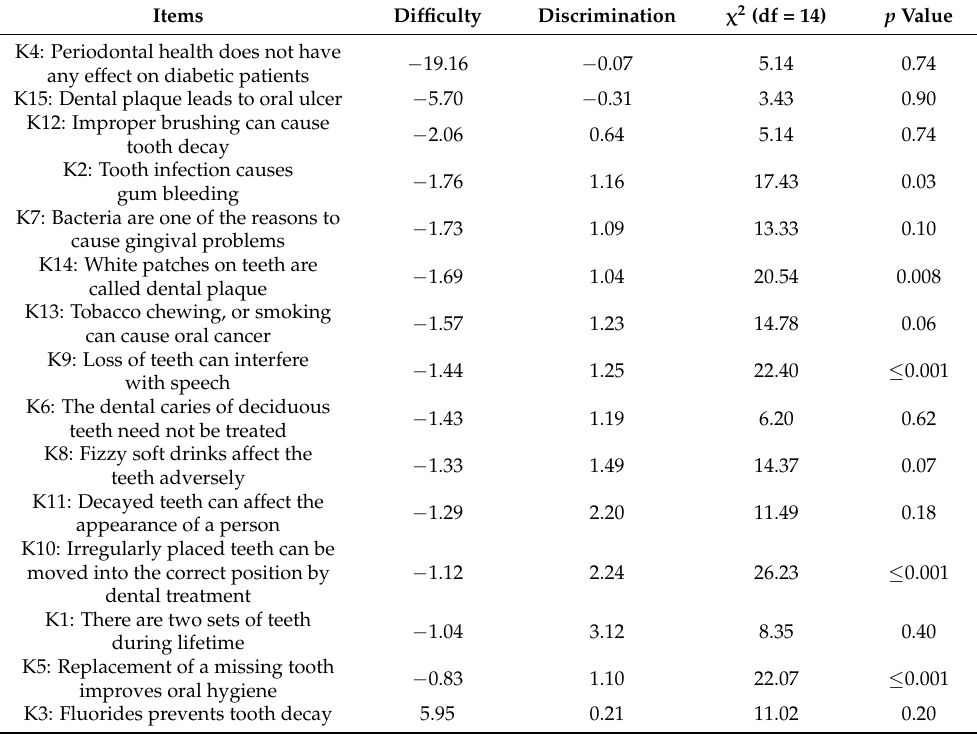
Table 3. Results of IRT for knowledge-based